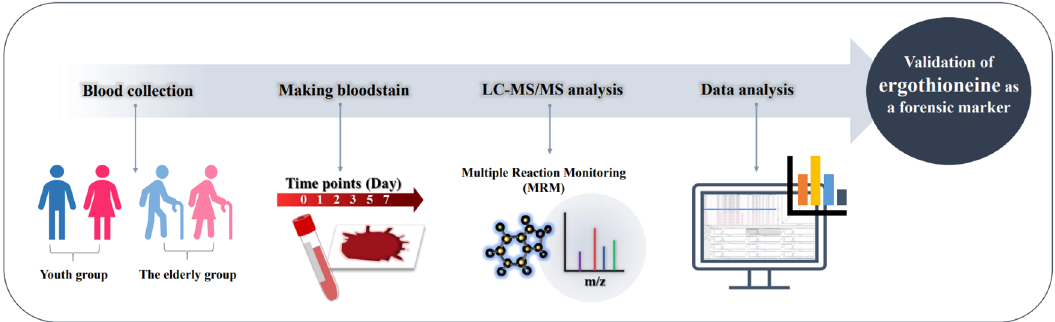
Figure 6. Experimental workflow. Bloodstains were produced with blood obtained from youth and elderly group individuals, and then metabolite extraction and target quantification were performed.